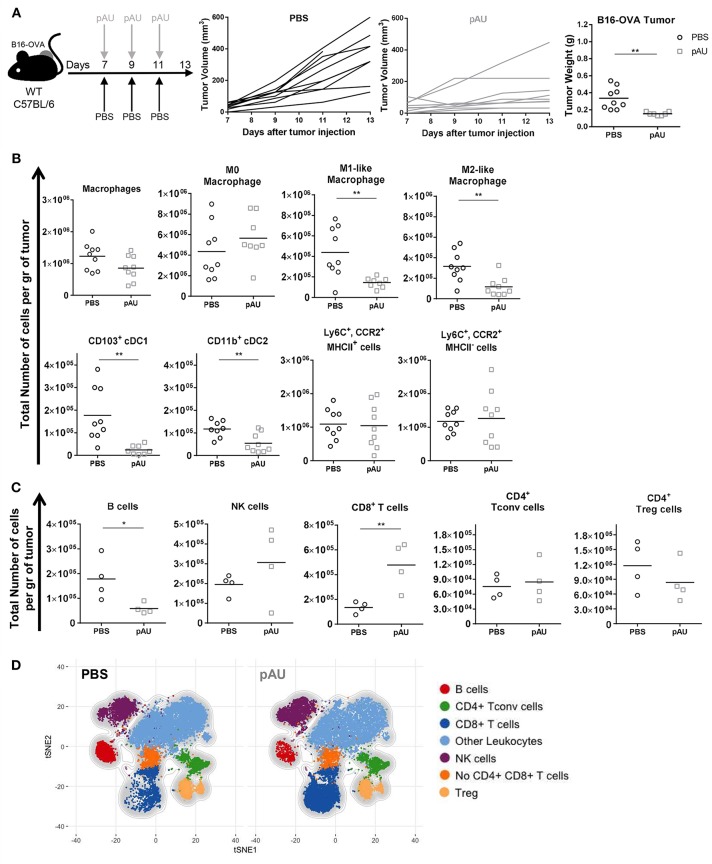
Poly A:U administration at the tumor site exhaustively modifies the tumor immune infiltrate. (A) WT C57BL/6 mice bearing B16-OVA tumors were intratumorally -treated with either poly A:U (100 μg/mice/dose) or PBS (control) every other day as indicated in the upper scheme. Plot of individual tumor volume of poly A:U and PBS groups. Tumor weight was evaluated at day 13 post-inoculation. (B) Total number of intratumoral myeloid cells per gram of tumor (density). (C) Total number of intratumoral lymphoid cells per gram of tumor (density). (D) tSNE plots showing concatenated flow cytometry data of intratumoral immune cells from mice treated with PBS (control) or poly A:U (pAU) showing the distribution of the lymphoid populations. Ex vivo analyses were performed at day 13 post-tumor inoculation. Data in (A–C) are shown as mean and pooled over two cohorts with significance determined by unpaired t-test. n = 9/group. *p < 0.05; **p < 0.01.